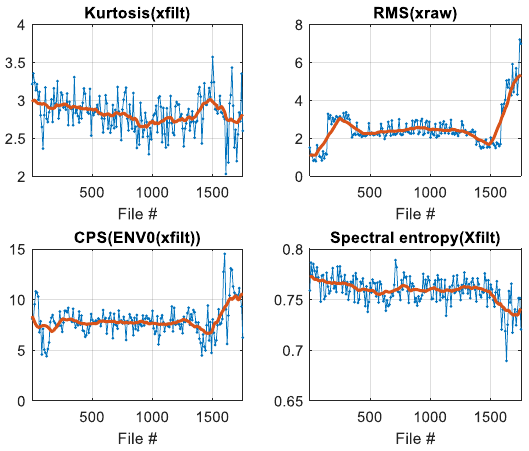
Figure 14. Fault severity indices (part 1), first frequency band—right TB.